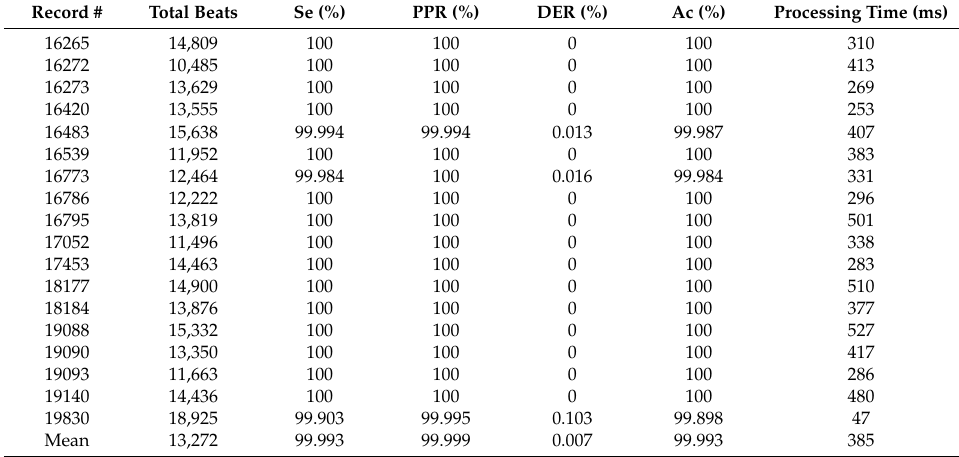
Table 3. Performance evaluation of the proposed method using the Massachusetts Institute of